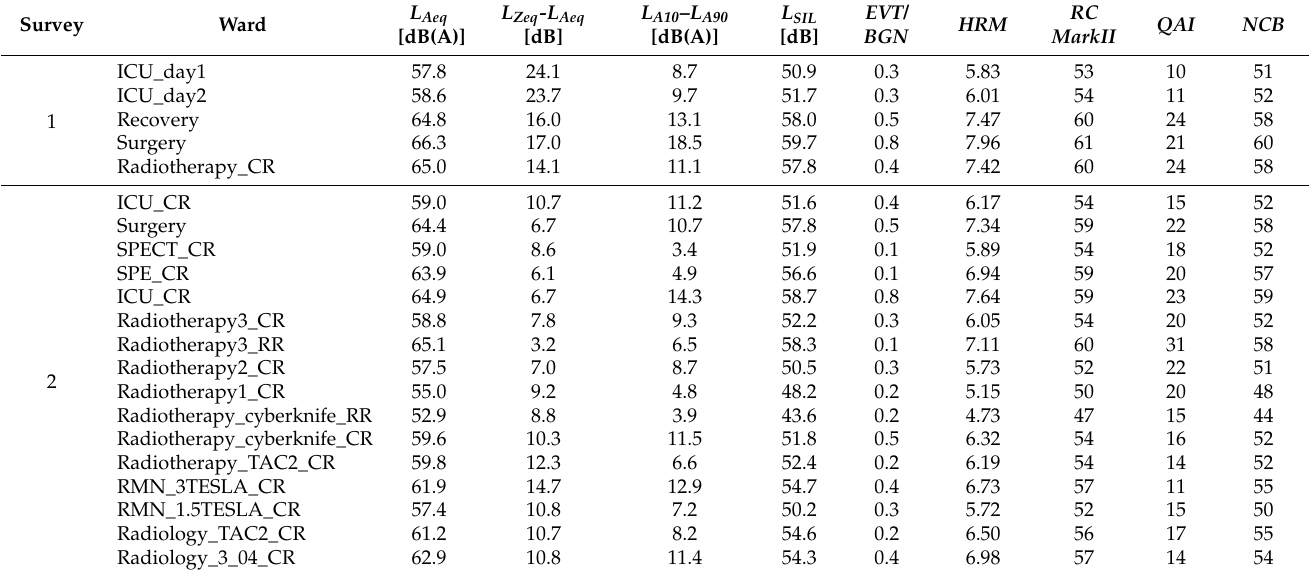
Table 4. Results of some acoustic metrics obtained by the developed R script.